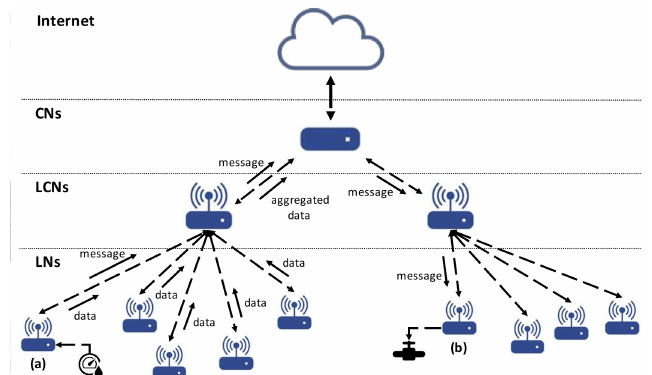
Figure 3. Example of a possible TR architecture based on the TR nodes. TR node ( a ) has a moisture sensor attached. Data measurements are assessed by the node and sent to the LCN, which gathers data from many different nodes and makes decisions or sends it to the CN. The CN can obtain data from both the LCNs and the Internet by service requests, and if the behavior is specified in its TR code, it can send an order to the TR node ( b ) to open or close the valve attached to